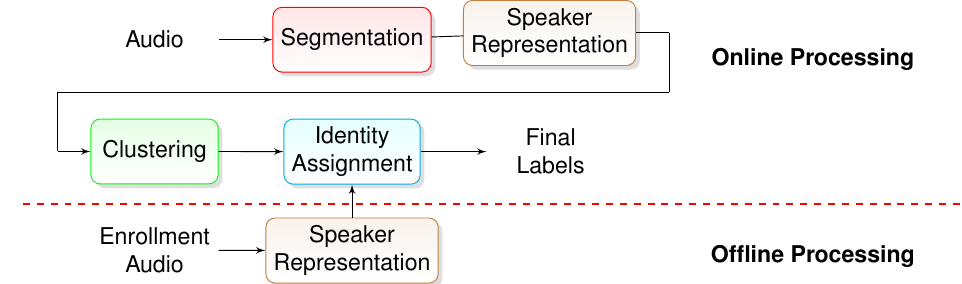
Figure 2. General block diagram for a speaker attribution